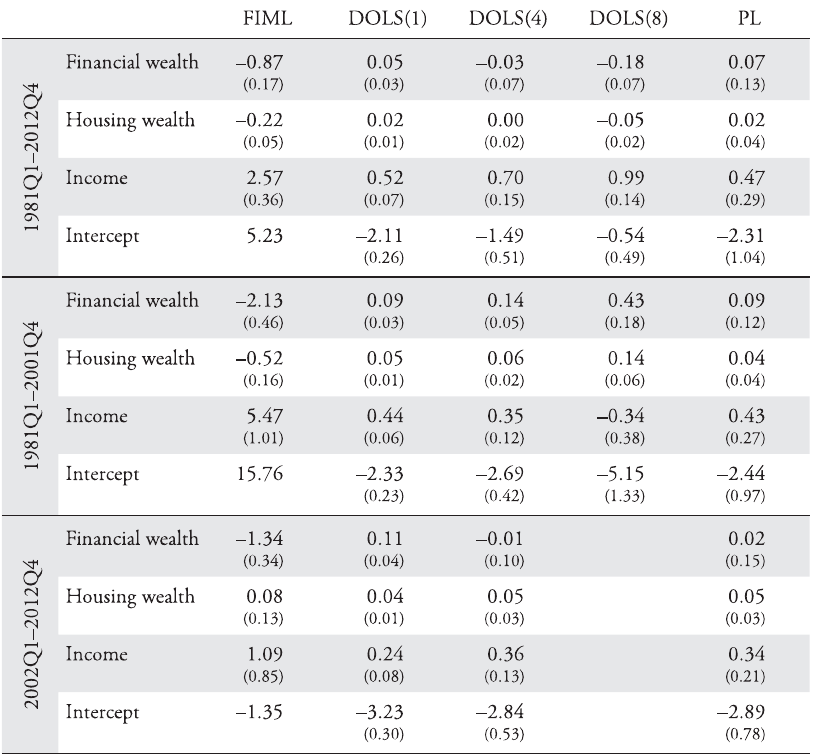
Table 6: Estimation of the Cointegrating Vector: Separate